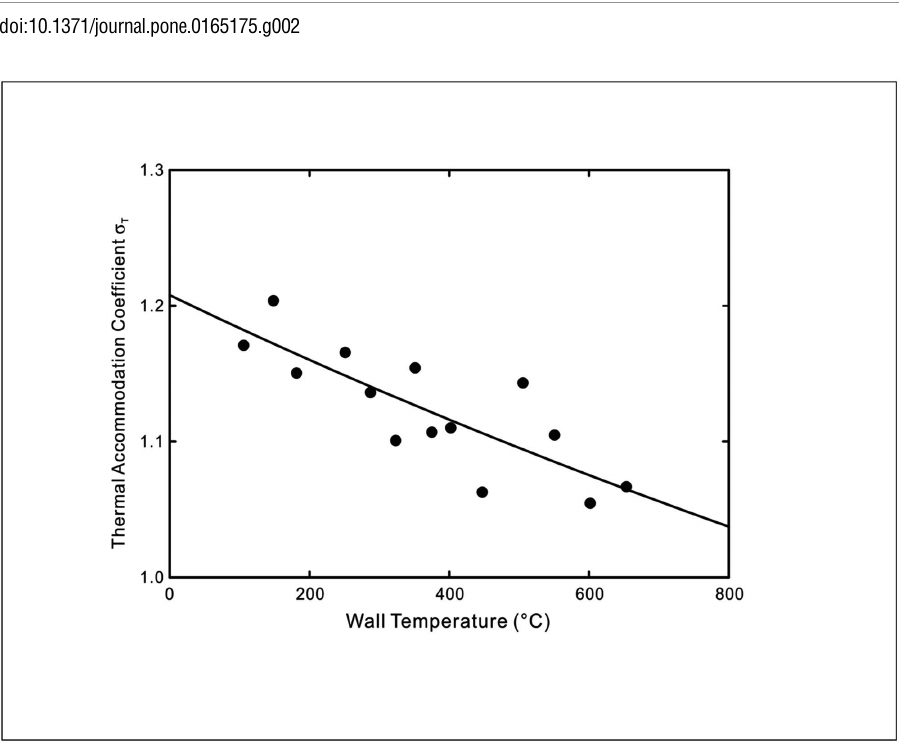
Fig 3. Temperature dependence of thermal accommodation coefficient of UO 2 sphere beds in argon. Symbols: Experimental data [12]. Line: Theoretical predictionusing Eq 10 with a = 0.828 and b = 1.702 × 10 − 4